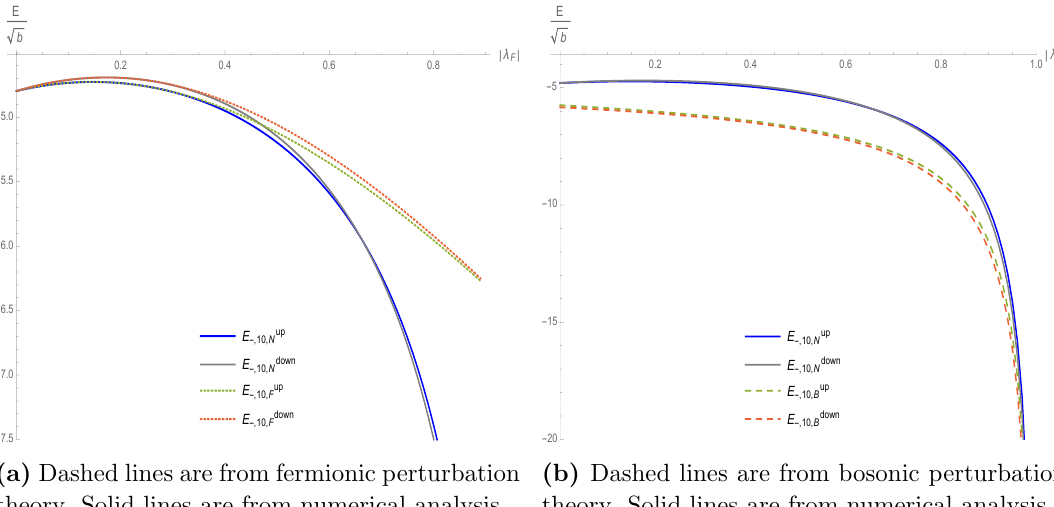
(a) Dashed lines are from fermionic perturbation (b) Dashed lines are from bosonic perturbation theory. Solid lines are from numerical analysis. theory. Solid lines are from numerical analysis. Figure 5. The critical chemical potentials for the M = 10 negative energy band as a function of p (cid:21) F for sgn(b (cid:21) F ) = (cid:0) 1 at (cid:12)xed m cri = (cid:0) j b j . B